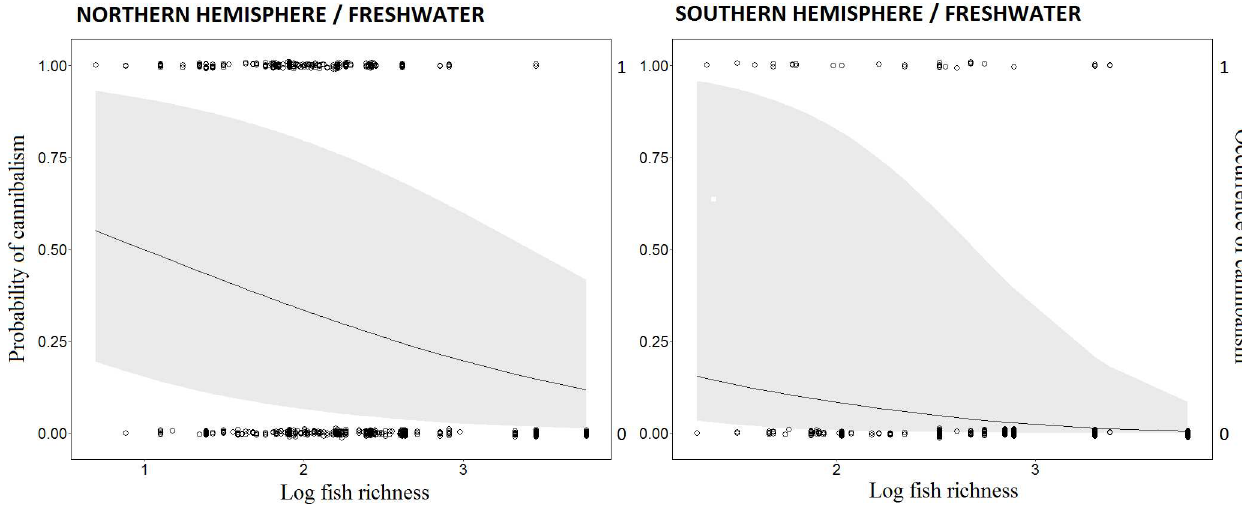
Fig 3. Generalized linear mixed models (GLMM) for the relationship between cannibalism occurrences and freshwater fish richness. Northernhemisphere (left side) and southern hemisphere (right side). Lines are the predictedcannibalism probabilityalong richness gradients accordingto each model. Shadedareas aroundprobabilities lines represent the 95% CI. Dots are observed data for absence(0) or presence(1) of cannibalism accordingto fish species richness.